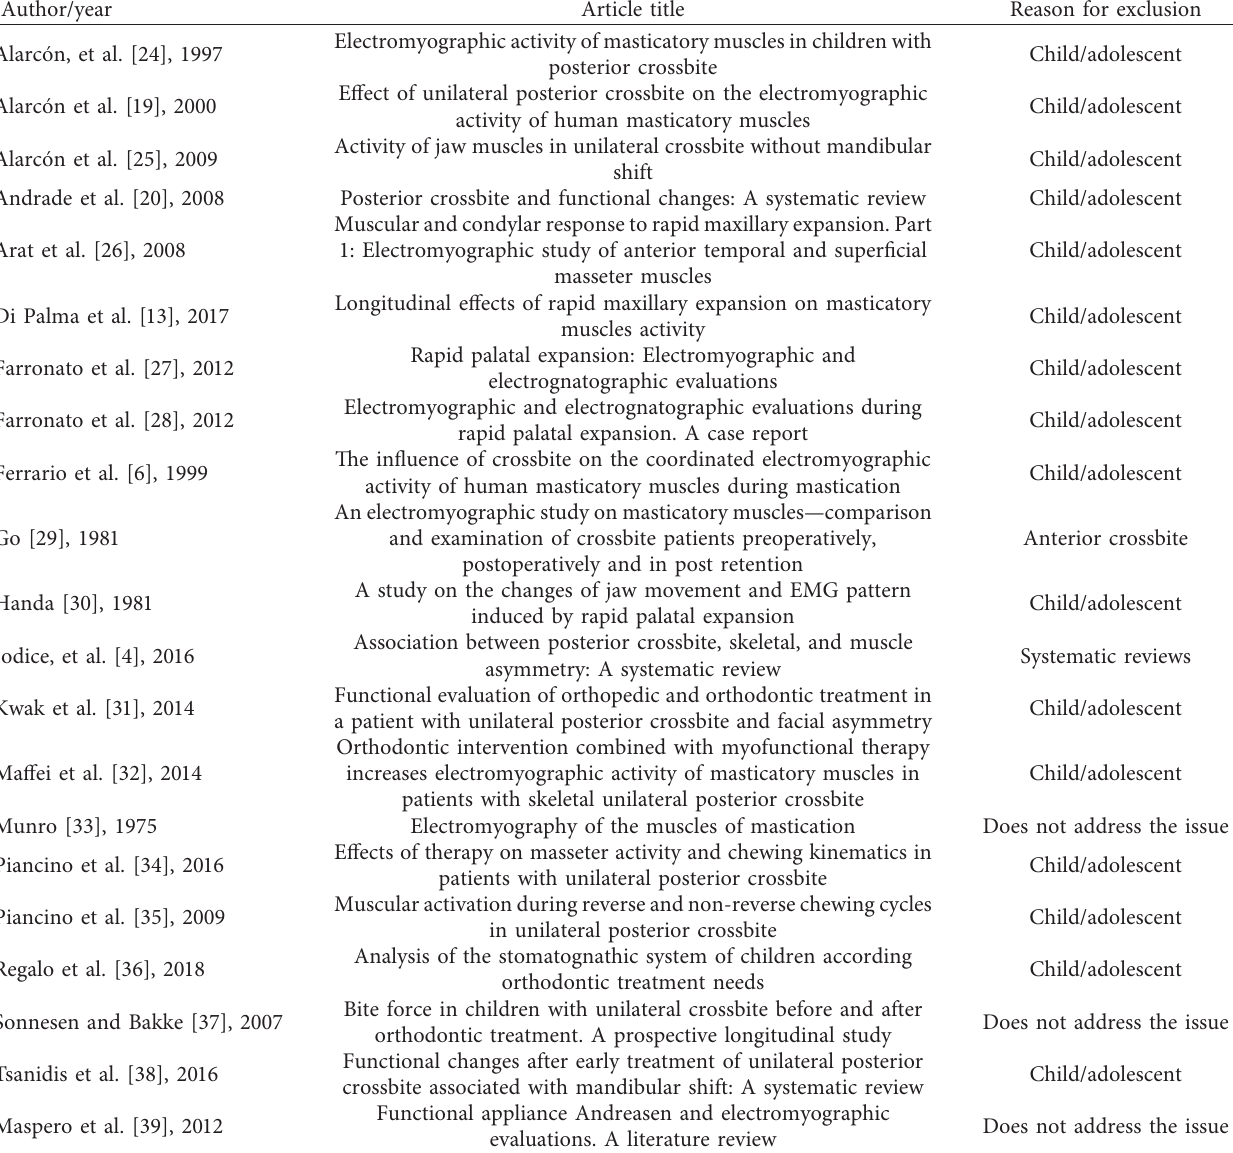
Table 2: List of excluded articles listed in alphabetical order of first author, with the principal reason for